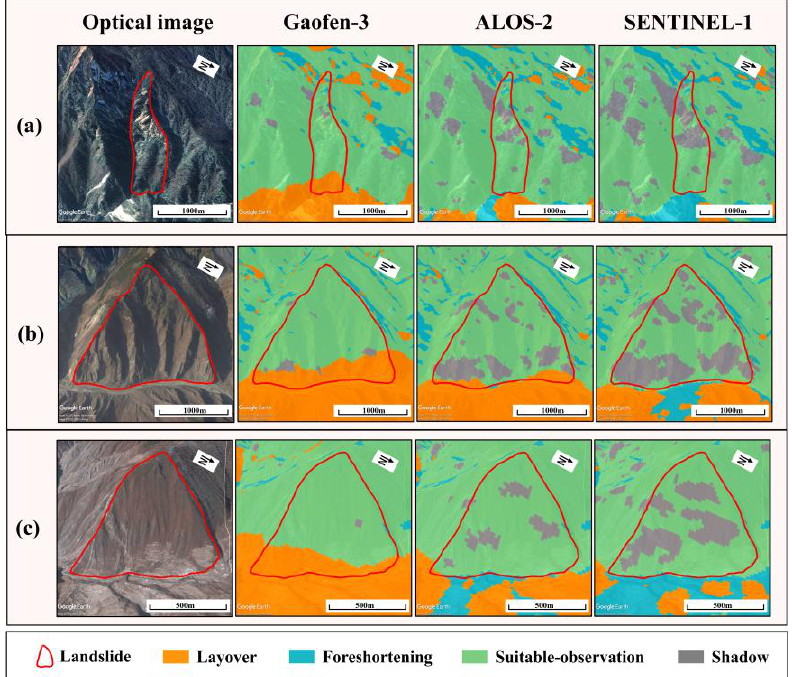
Figure 11. ( a – c ) Comparison of slope imaging for the far-away-from-satellite slopes.